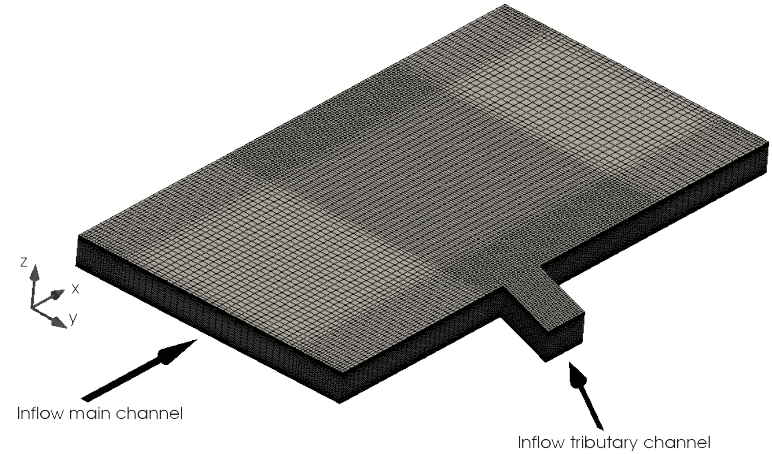
Figure 6. Computational domain of the